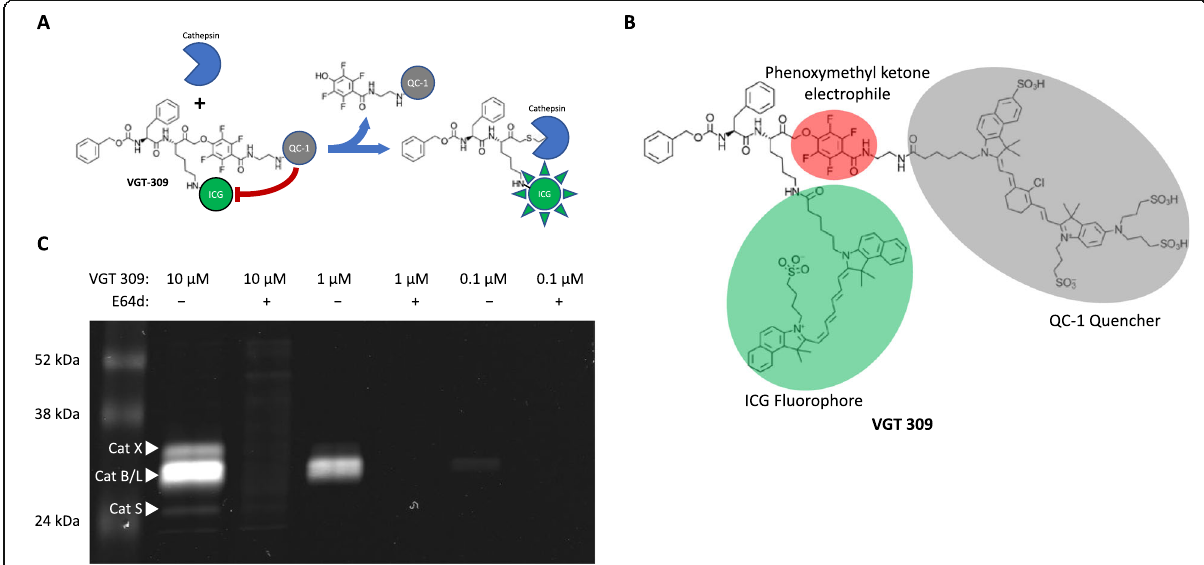
Fig. 1 Mode of action and structure of VGT-309 and in vitro binding to active cysteine cathepsins. a Mode of action of VGT-309. Cathepsins covalently and irreversibly bind VGT-309, displacing the quencher QC-1. With the quencher displaced, the ICG fluorescence of VGT-309 is no longer quenched and the probe becomes fluorescent. b Structure of VGT-309. The phenoxymethyl ketone electrophile (red) forms a covalent bond with the active cysteine of cathepsins. The fluorophore ICG (green) is for visualization and the quencher (gray) prevents fluorescent signal in the free, unbound probe. c VGT-309 labeling of endogenously expressed cathepsins in RAW-264.7 cells. Cells were treated with probe for 30 min in the presence or absence of cysteine cathepsin inhibitor E64d followed by lysis and analysis by SDS-PAGE and scanning for fluorescent labeled proteins. The locations of cathepsin X, B/L, and S are